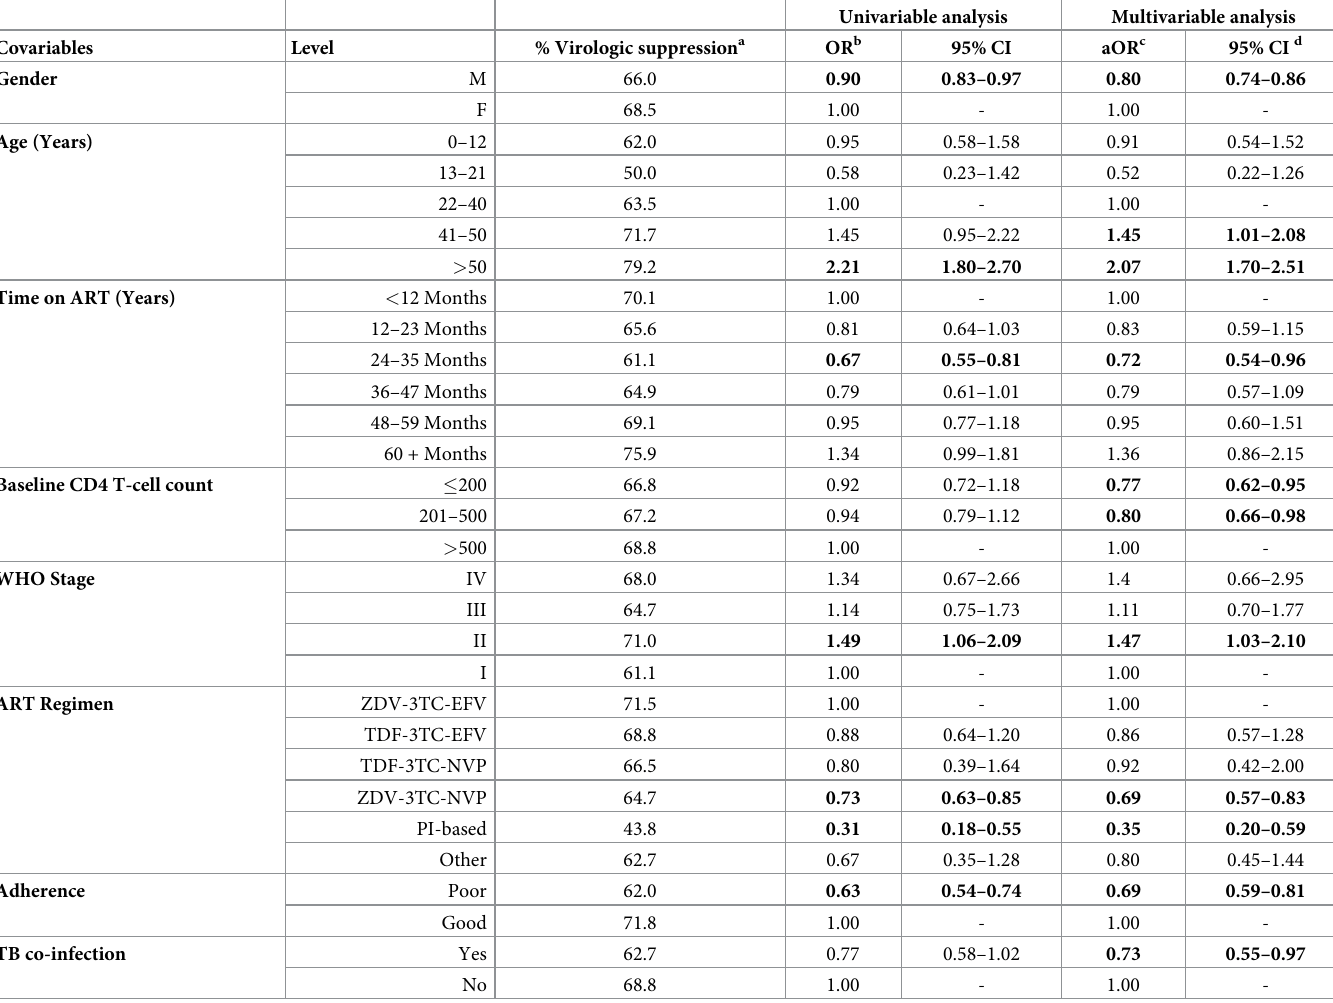
Table 2. Factors associated with viral suppression using univariable and multivariable logistic regression models.